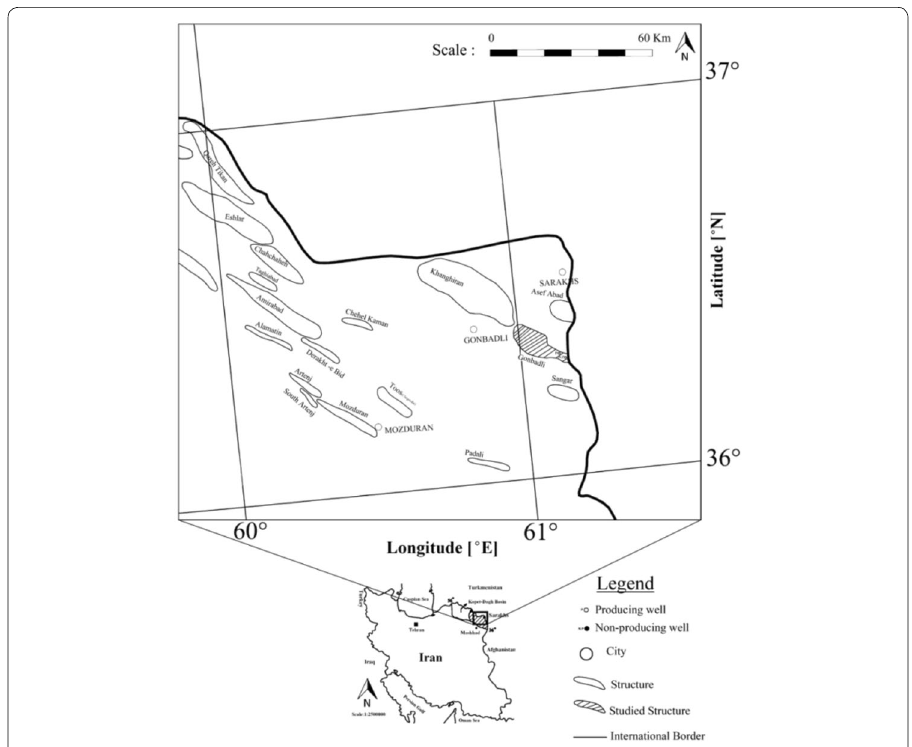
Fig. 1 The geographic location map of the studied area, modified from